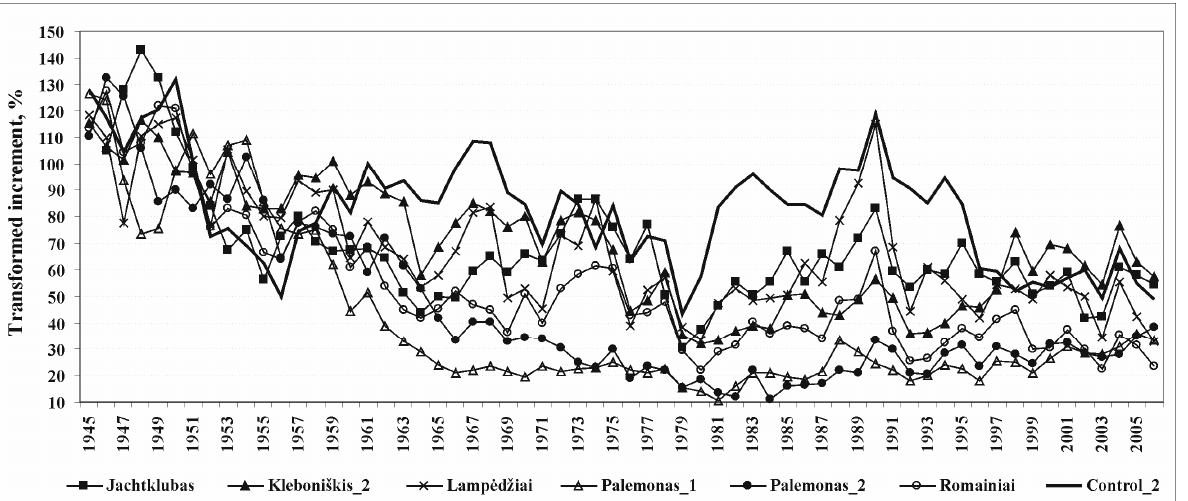
Fig. 4. Transformed dendroscales of 80 – 90 year old pines in Control_2 and Kaunas city sample